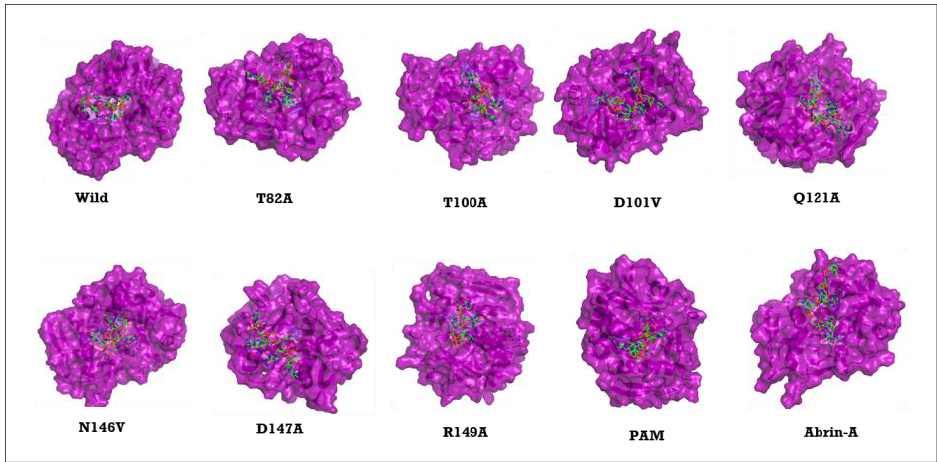
Figure 4. Complex structure of toxins or mutants with ligand (CGAGAG). Each snapshot was extracted from the last frame (t = 100 ns) of the trajectory.